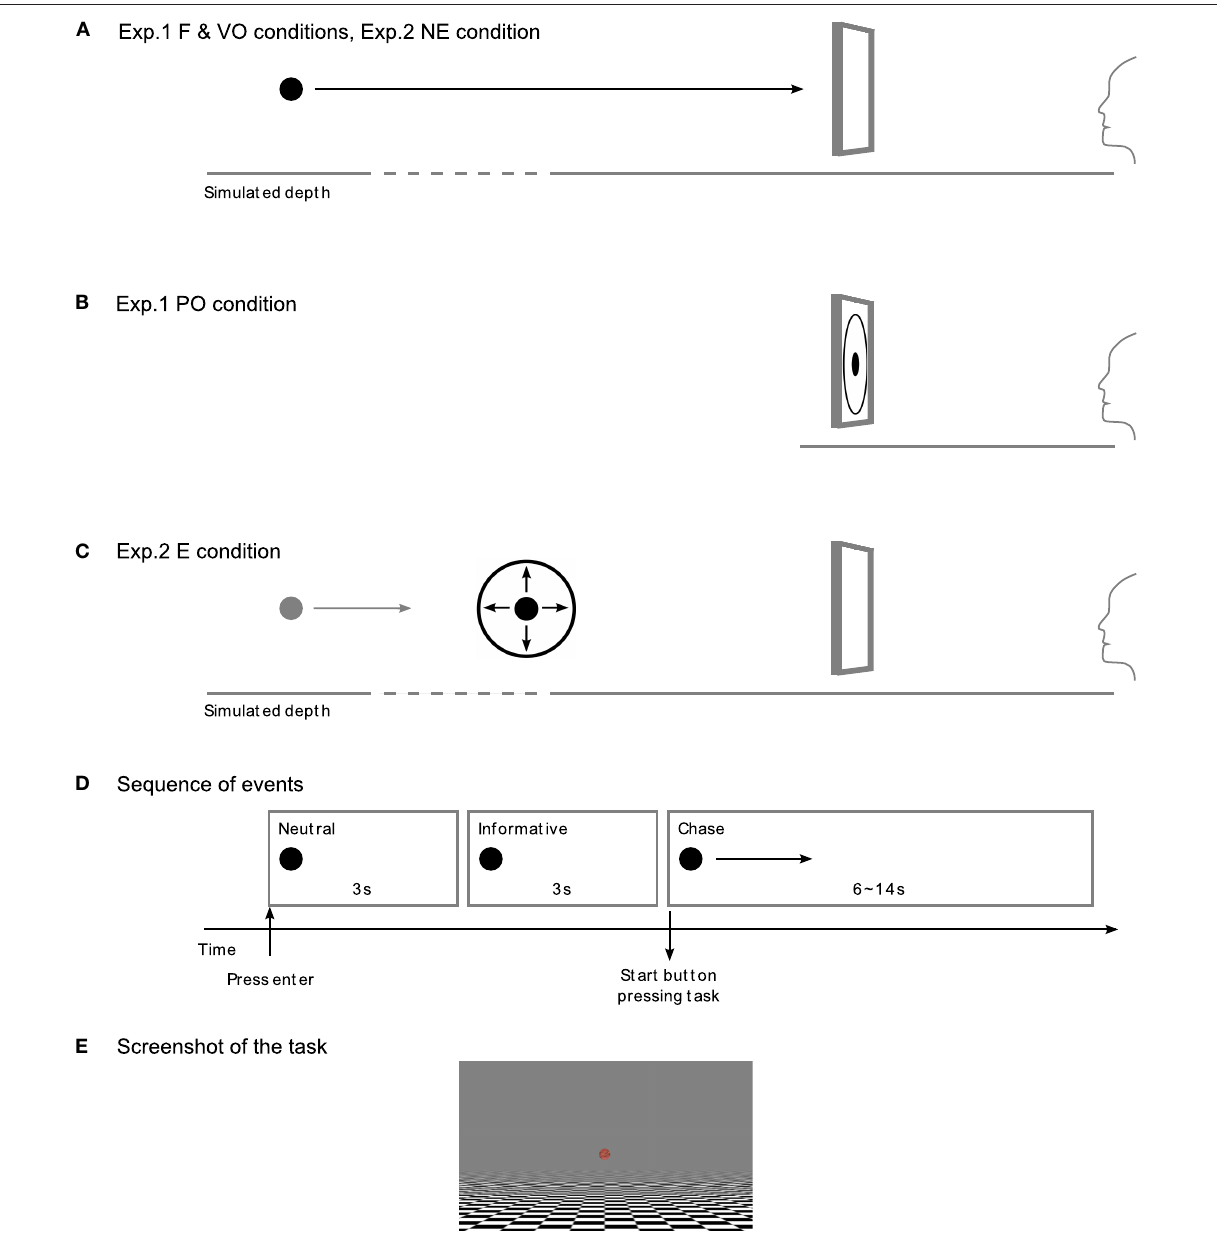
stopped moving and expanded to simulate the same progress as in the NE condition (C) . The sequence of events during the trial was started by the subject “pressing enter,” and was composed of a 3-s neutral phase followed by a 3-s informative phase, after which the chase commenced, lasting for 6–14 s, depending on the trial (D) . A screenshot of the display during the task, with perspective cue